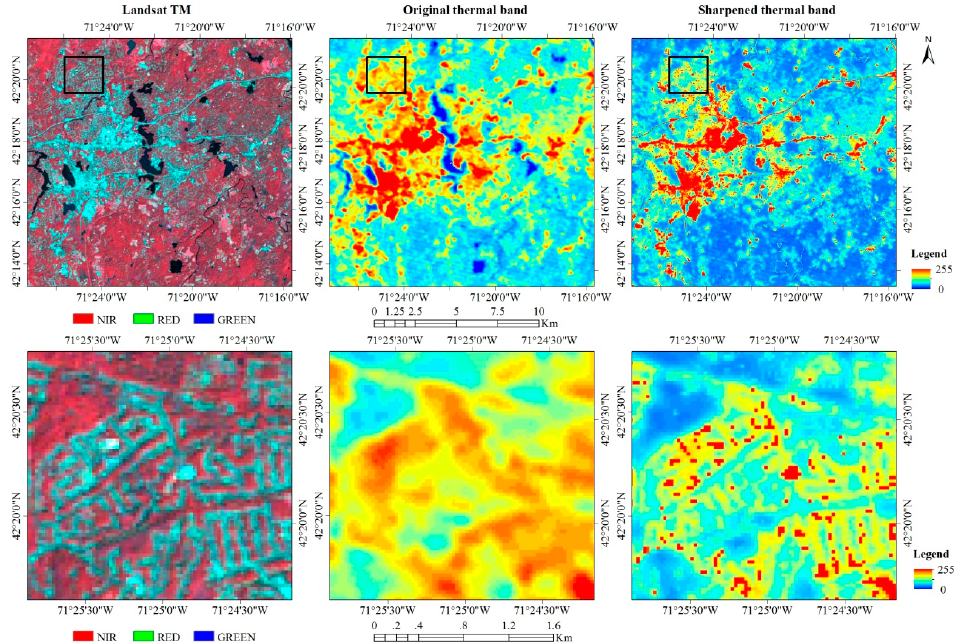
Figure 4. Sharpening of the TM image acquired on 30 August 2010: the first column is the standard false color display; the second column represents the original thermal band; and the last column denotes the sharpened thermal band. An example subset is shown in the second line of each column.